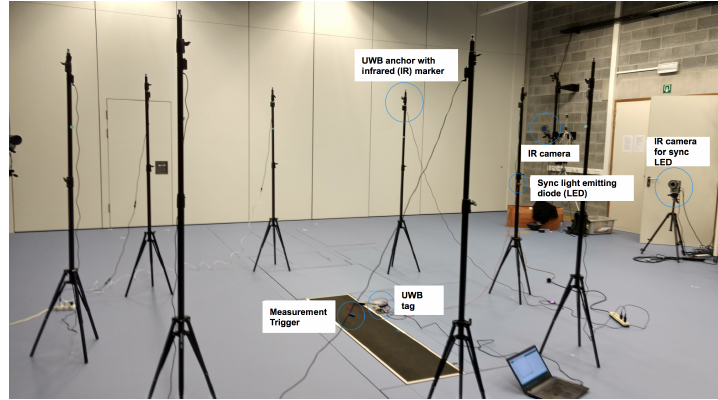
Figure 6. Sport Science Laboratory–Jacques Rogge of Ghent University, wherein eight UWB anchors are installed to position a mobile